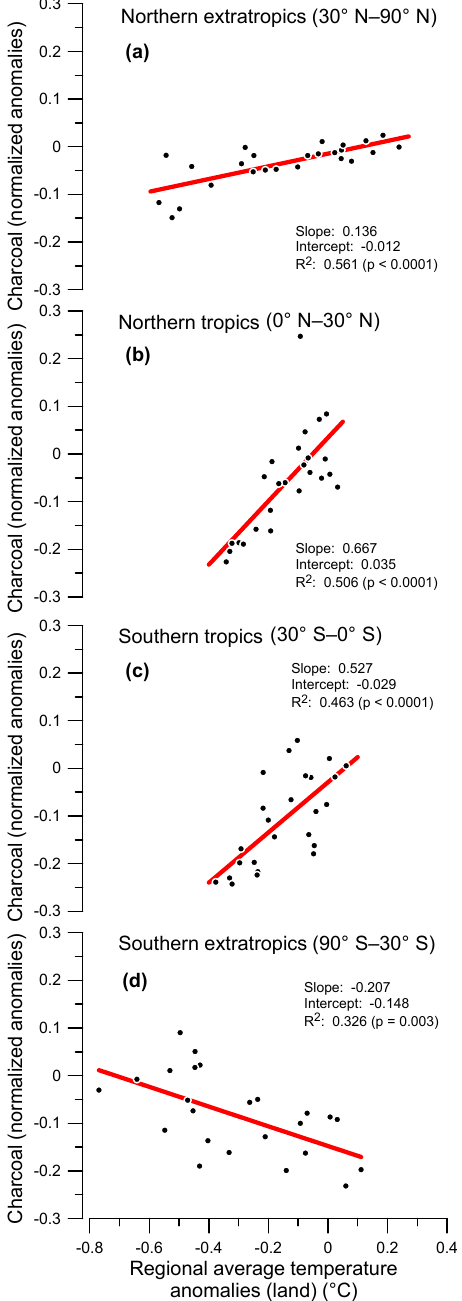
Figure 6. Relationship between normalized charcoal anomalies and land temperature for the (a) northern extratropics, (b) northern trop- ics, (c) southern tropics, and (d) southern extratropics. The data points refer to 50-year binned